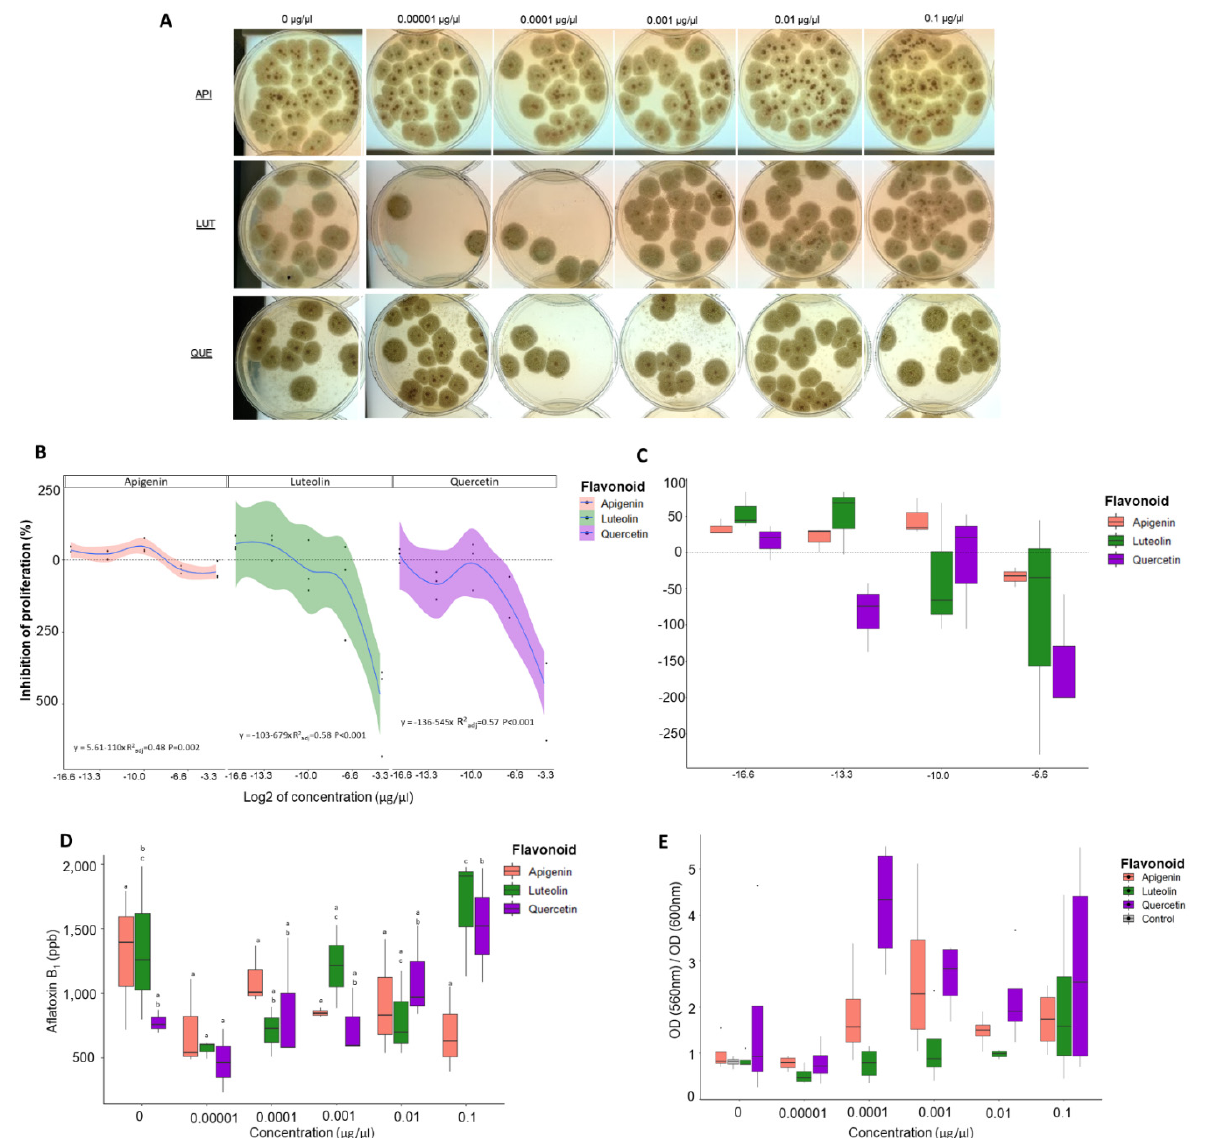
Figure 2. Effect of flavonoids on proliferation, aflatoxin production, and cell metabolism of A. flavus 70-GFP. Biological assays performed with AF70 (GFP tagged) strain exposed to apigenin, luteolin, and quercetin at 0 (1% DMSO only), 0.00001, 0.0001, 0.001, 0.01, and 0.1 µg/µL concentra- tions. ( A ) Pictures of Petri dishes from proliferation assays. ( B ) Regression analysis of inhibition of proliferation and flavonoid concentration. Regression formula includes adjusted R 2 and p -value; log 2 concentration was only used for scaling, not for regression. ( C ) Box plots of inhibition of proliferation (highest concentration (0.1 µg/µL) was excluded). ( D ) Concentration of aflatoxin B1 (ppb). ( E ) MTT assay results expressed as the ratio of OD 560 nm/OD 600 nm. Key color legend represents chemical used, with salmon: apigenin, green: luteolin, purple: quercetin, and gray: control (0% DMSO). Different letters over box plots represent significant difference according to Tukey HSD assay ( p < 0.05) for aflatoxin B 1 performed separately by flavonoid. Box plot whiskers depict the maximum and minimum without outliers, and the box depicts median and first and third quantile distribution. n = 3 per treatment. For Figure 2E, the dots are outliers .